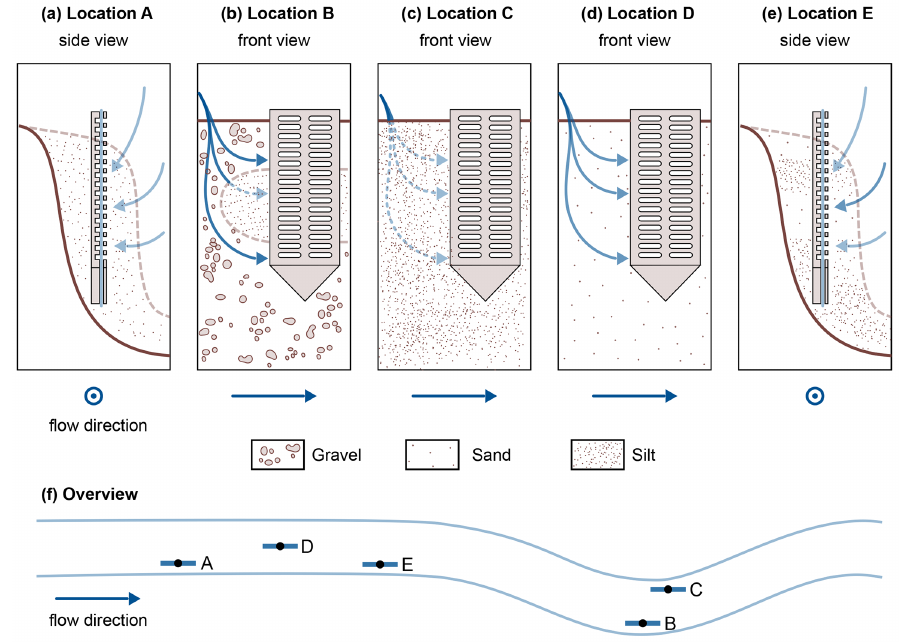
Figure 3. Schematic representation of potential hyporheic flow paths (blue arrows) at the five sampling sites. For locations A and E, a side view was chosen, and for locations B, C and D a front view was used. Where the front view is shown, flow direction in the river is from left to right, and where the side view is shown, flow direction is out of the drawing plane. The color strength of the arrows corresponds to the expected magnitude of hyporheic fluxes. The sediment composition is schematically indicated. Quantitative data on the sediment composition at the five locations can be found in Sect.